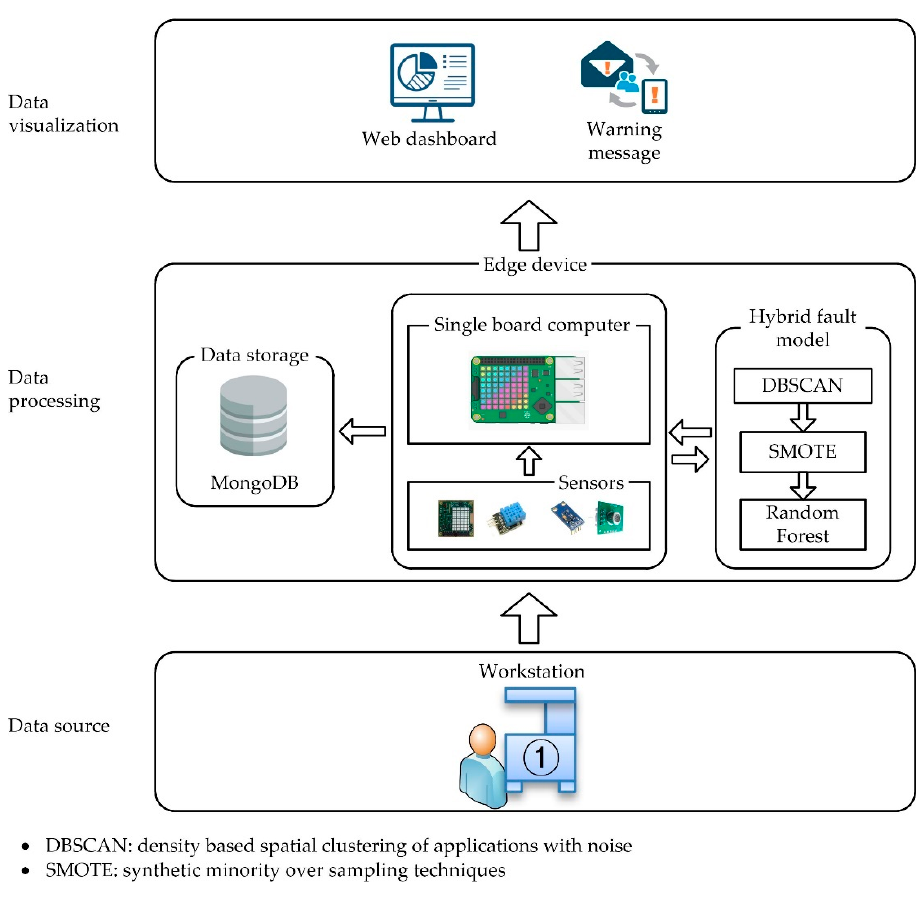
Figure 1. Proposed affordable fast early warning system (AFEWS) architecture.